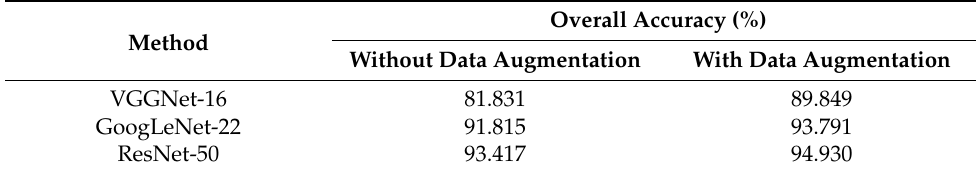
Table 2. Comparisons of OA for base networks with and without data augmentation.